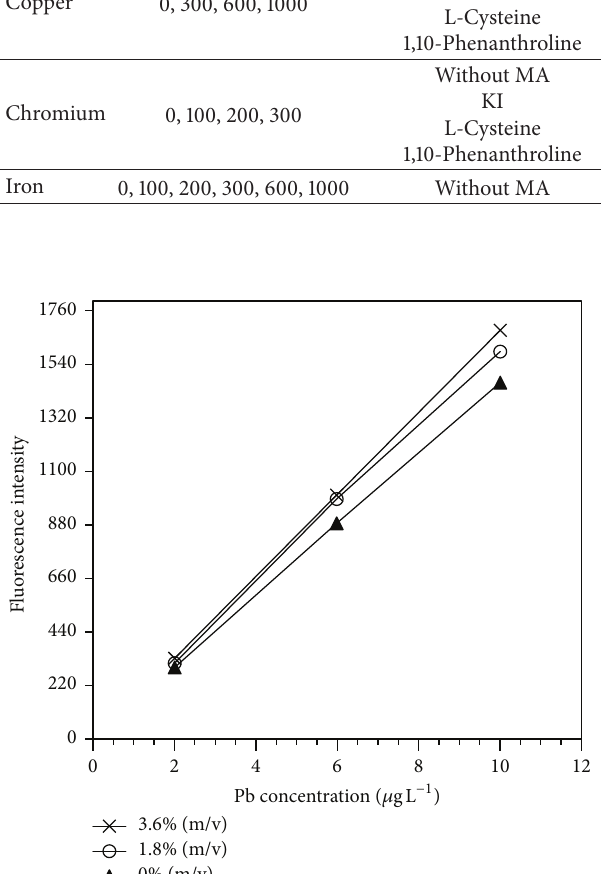
Figure 2: Calibration curves for lead obtained in the presence of different concentration of KI added to the reducing solution. Reactionconditions:1%(m/v)KBH 4 ,1.5%(v/v)HCl,and1.5%(m/v) K 3 [Fe(CN) 6 ].